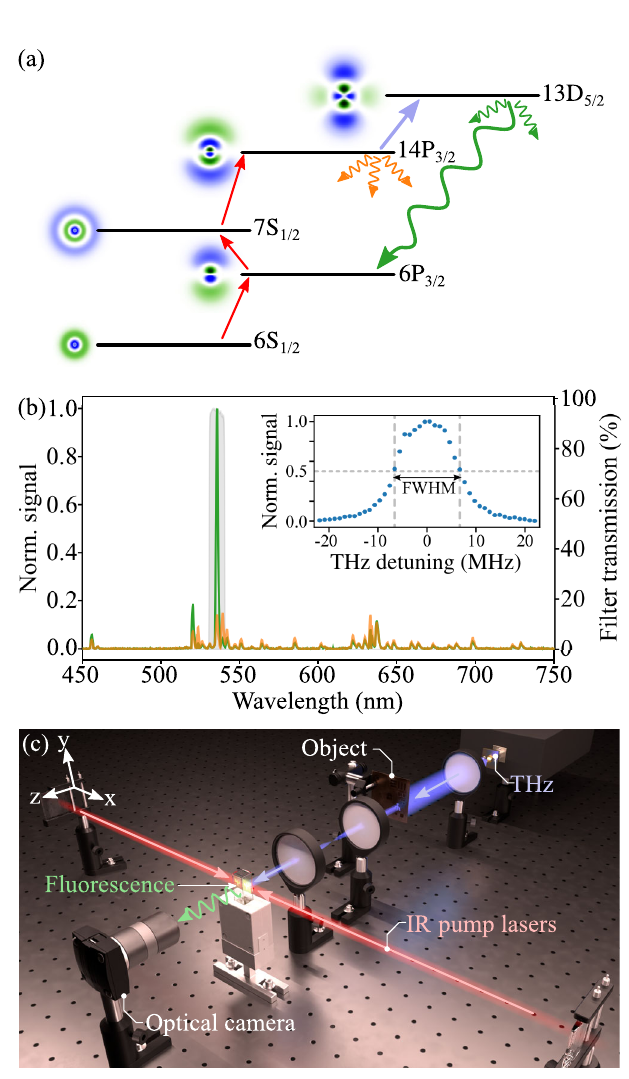
FIG. 1. THz imaging using atomic vapor. (a) The internal energy structure of caesium, highlighting the excitation and principal decay pathways used in this work. The red arrows correspond to laser excitations, the purple arrow to the excitation driven by the THz field, and the orange and green arrows to optical fluorescence emitted by decay from the 14 P 3 = 2 and 13 D 5 = 2 states, respectively. The large green arrow represents the principal decay pathway. (b) The spectral characteristics of the fluorescence from the vapor, both with and without the THz field (green and orange lines, respectively). The shaded region highlights the optical filter used to isolate the spectral region of interest. Inset: The dependence of the fluorescence signal on THz detuning, from which we extract a linewidth of ð 14 . 0 (cid:2) 0 . 4 Þ MHz. (c) A diagram of the imaging setup described in this work. Infrared pump lasers form a sheet of excited caesium atoms contained within a quartz cell. The THz field passes through an object that is imaged onto the atoms using PTFE lenses. Interaction of the THz field with the excited atoms leads to the emission of green fluorescence, which is captured using an optical